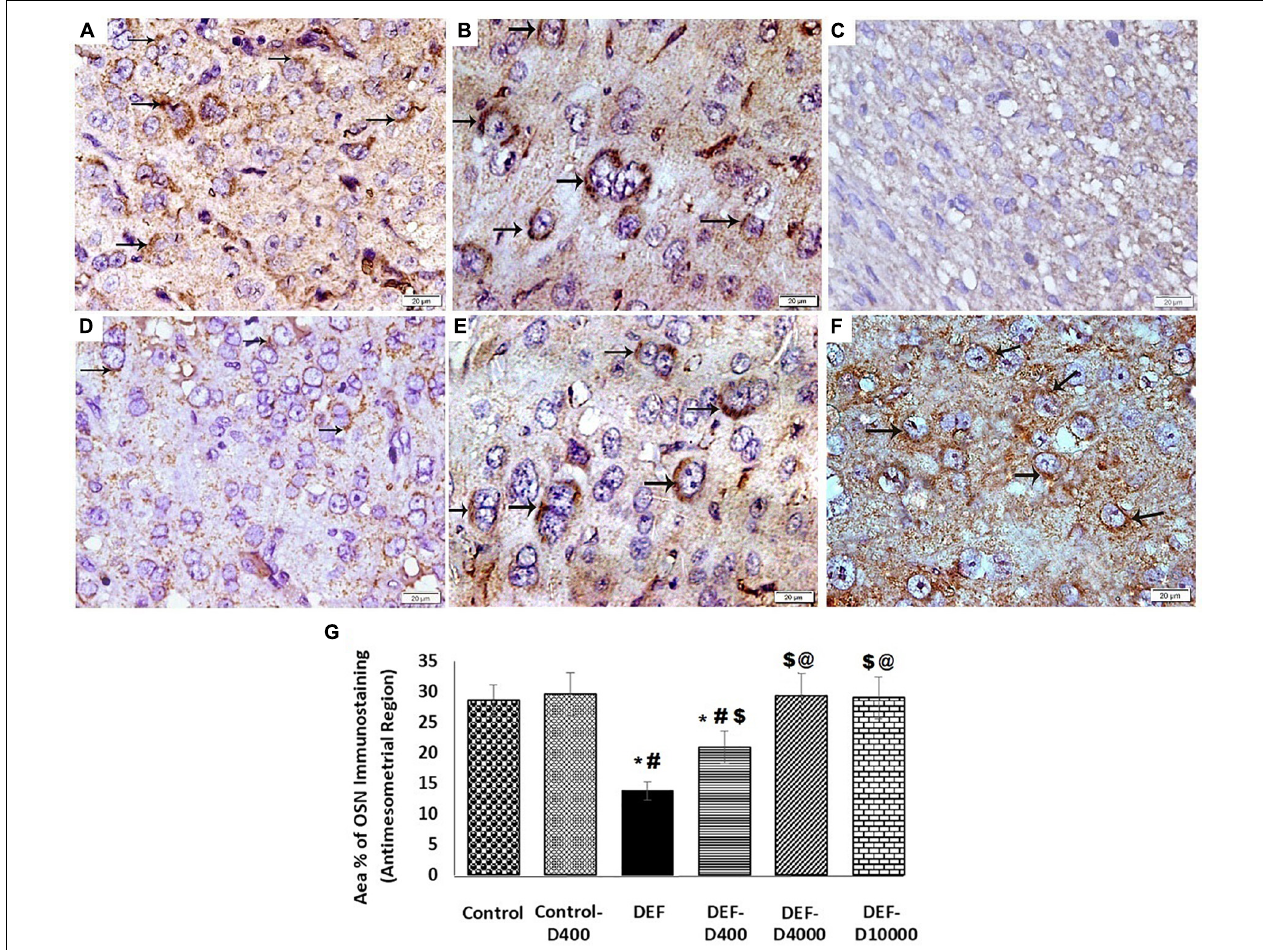
FIGURE 8 | Photomicrograph of osteopontin (OSN) immunostained sections of the antimesometrial region of the rat uteri at 8th day of pregnancy ( × 400): (A) Control and (B) Control-D400 revealing strong cytoplasmic immunostaing of OSN in many decidual cells (arrows). (C) DEF displaying weak cytoplasmic immunostaining of OSN in few cells. (D) DEF-D400 illustrating moderate cytoplasmic immunostaining of OSN in some cells. (E) DEF-D4000 and (F) DEF-D10000 demonstrating strong cytoplasmic immunostaing of OSN in many decidual cells (arrows). Scale bar 20 µ m. (G) Quantification of the mean area % of OSN positive immunostaining in the antimesometrial region of the rat uteri at 8th day of pregnancy. D: refers to vitamin D supplementation in different doses equivalent to 400, 4,000 and 10,000 IU. DEF: refers to vitamin D deficiency ∗ : Statistically significant sign compared to the control group, # : compared to control-400, $: compared to the deficiency group, and @: compared to DEF-400 ( P <